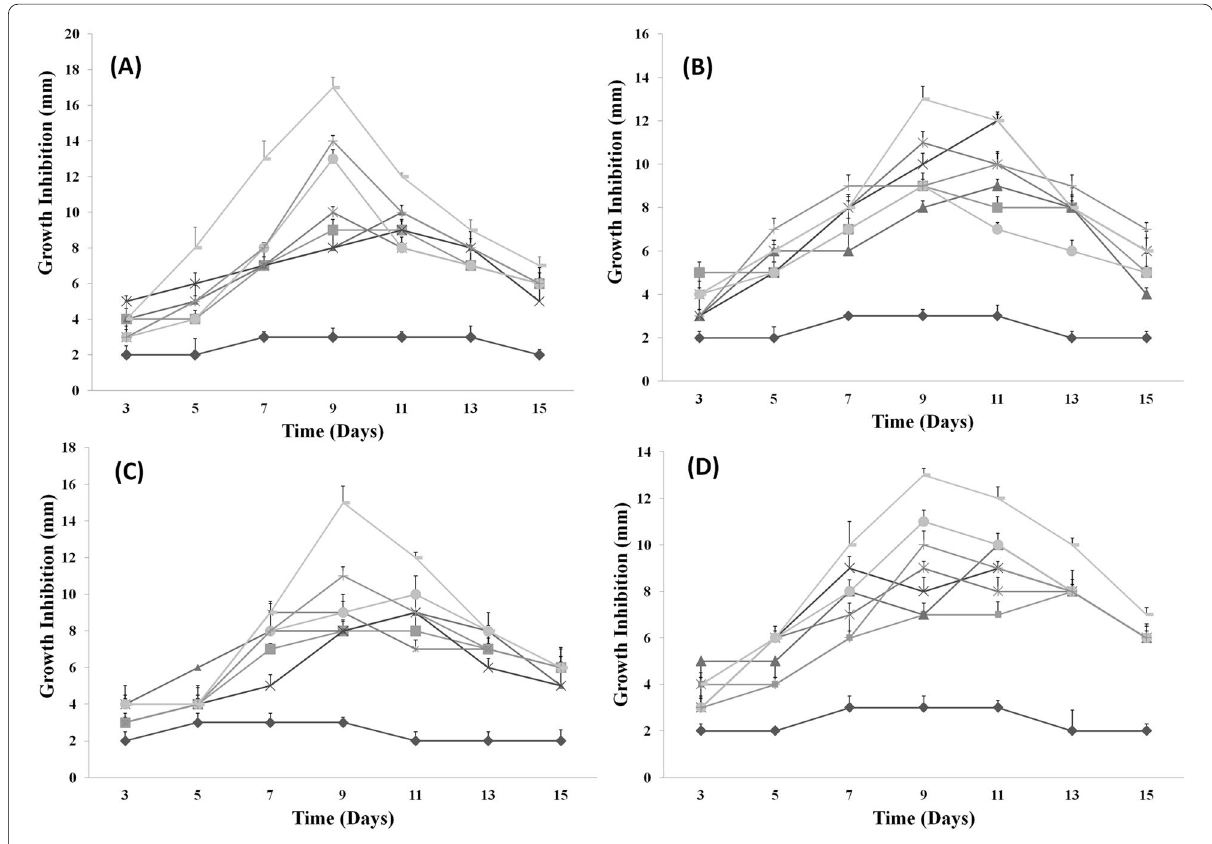
Fig. 5 Antimicrobial activity of JB140 WT strain and evolved JB140 Pv , JB140 St , JB140 Sa , JB140 Sa,St , JB140 Sa,Pv , JB140 St,Pv , and JB140 Sa,St,Pv mutants against Salmonella Typhi ( A ), Staphylococcus aureus ( B ), Proteus vulgaris ( C ) and a clinical MDR uropathogenic Escherichia coli (UPEC 1021) ( D ). Values represent the mean SD for three ±